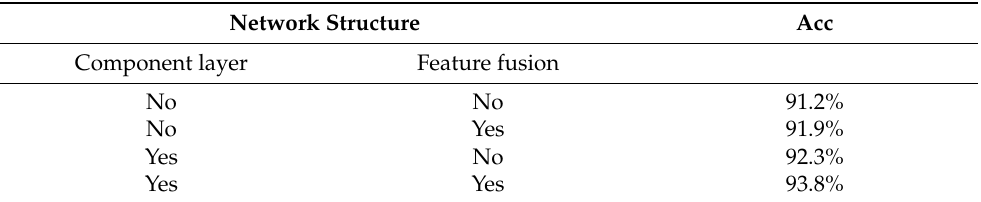
Table 6. Feature fusion and composition layer influence